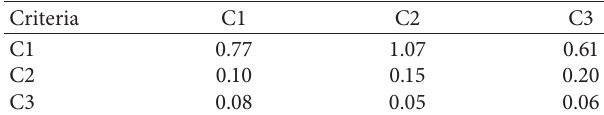
Table 5: Weighted matrix.